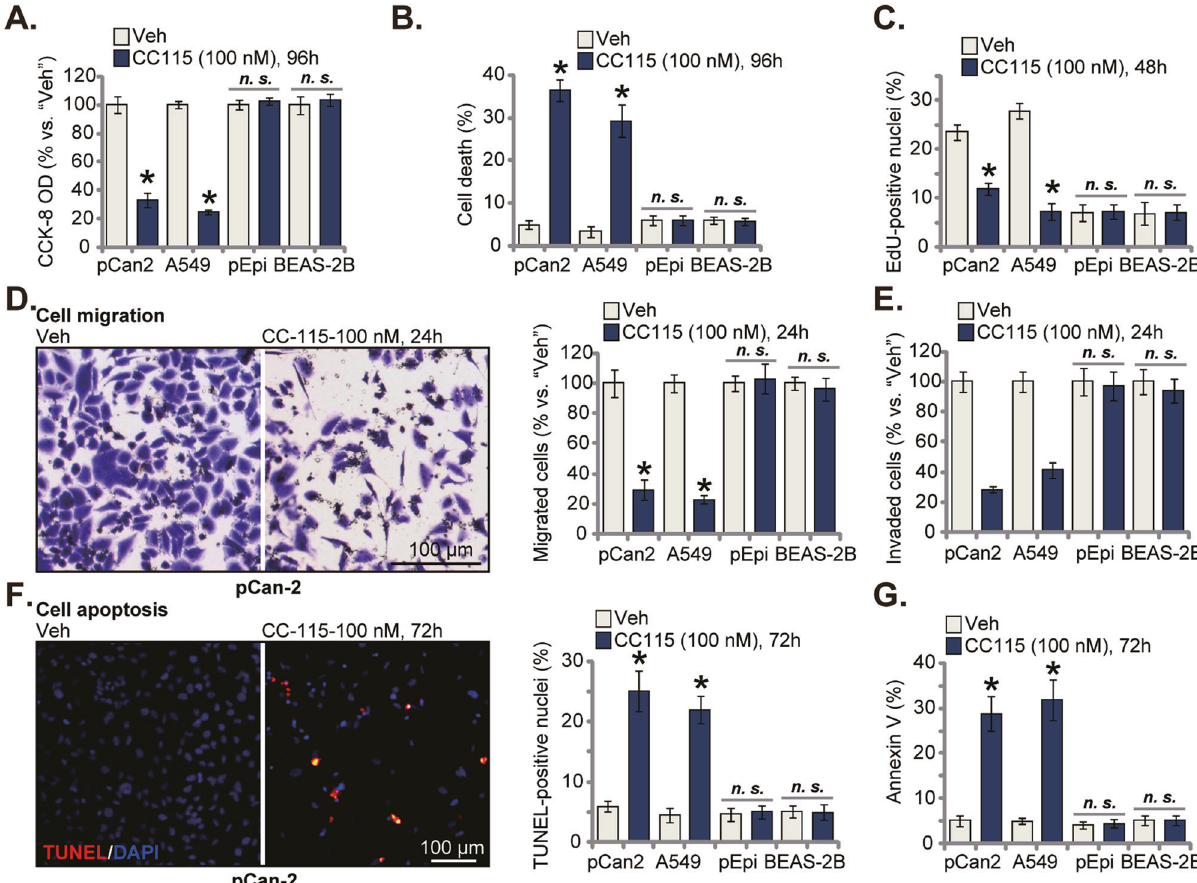
Fig. 3 CC-115 exerts different activity in NSCLC cells and lung epithelial cells. pCan2 cells, the immortalized A549 NSCLC cells, the primary human lung epithelial cells ( “ pEpi ” ) or the BEAS-2B bronchial epithelial cells were treated with CC-115 (100 nM) and cultivated for the designated time periods; Cell viability (CCK-8 OD, A ), cell death ( B ) and proliferation (by testing the nuclear EdU percentage, C ), cell migration ( D ) and invasion ( E ) were tested. Cell apoptosis was measured by the nuclear TUNEL staining assay ( F ) and Annexin V fl ow cytometry ( G ). For each assay, n = 5. * P < 0.05 versus “ Veh ” group. “ n.s . ” stands for non-statistical difference. Scale bar = 100 μ m ( D